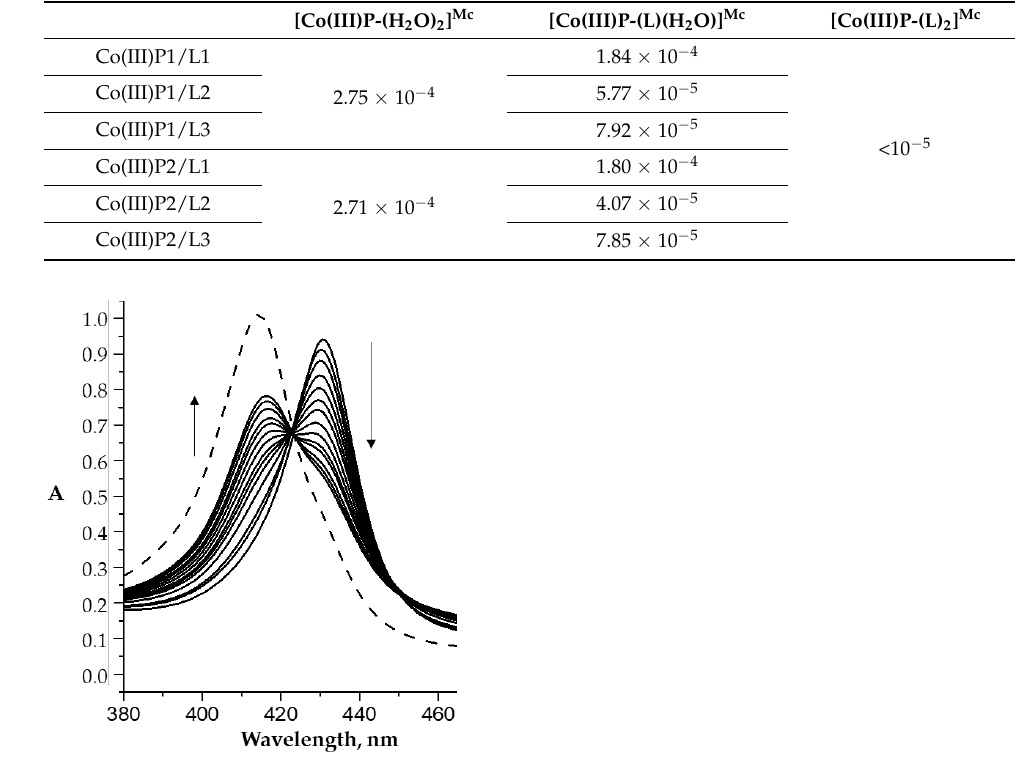
Figure 10. The reduction processes of [Co(III)P1(H 2 O) 2 ] Mc into [Co(II)P1 Mc in phosphate buffer (pH 7.4) during 150 min at T = 40 °С.